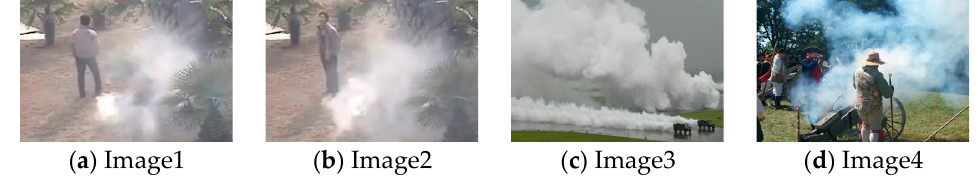
Figure 4. Smoke images for parameter analysis.